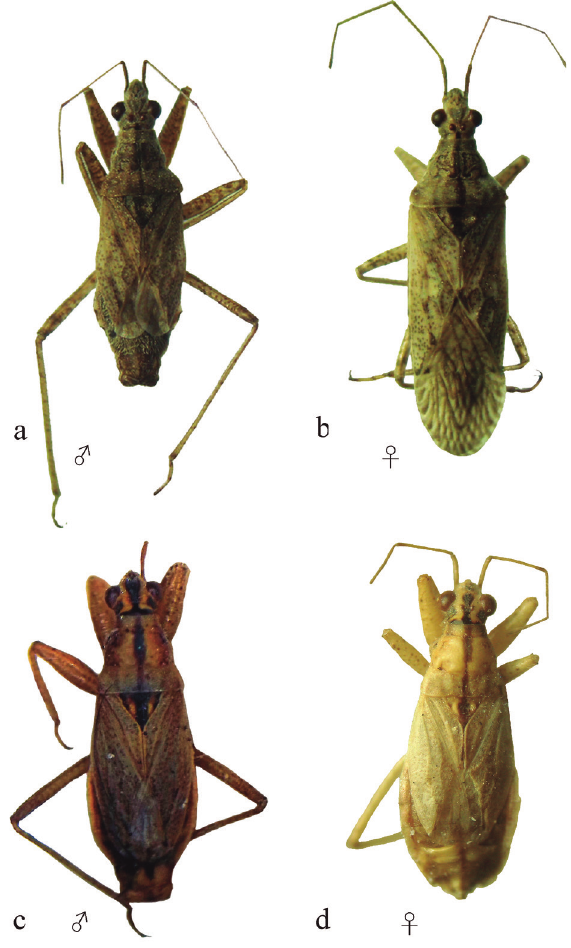
Figure 1. Dorsal view. a-b, Nabis ( Austronabis ) argentinus . c-d, N . ( A .) faminei